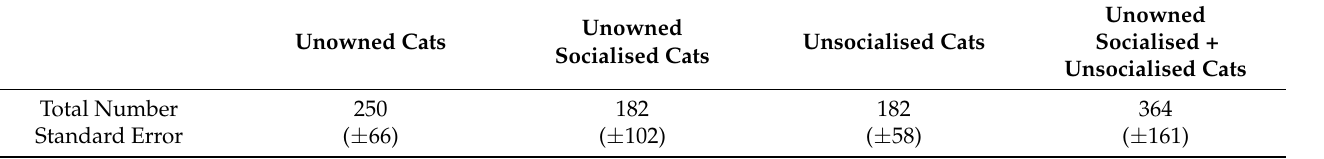
Table 3. Estimated population of unowned free-ranging cats in the Danish harbours, and standard error (SE, shown in